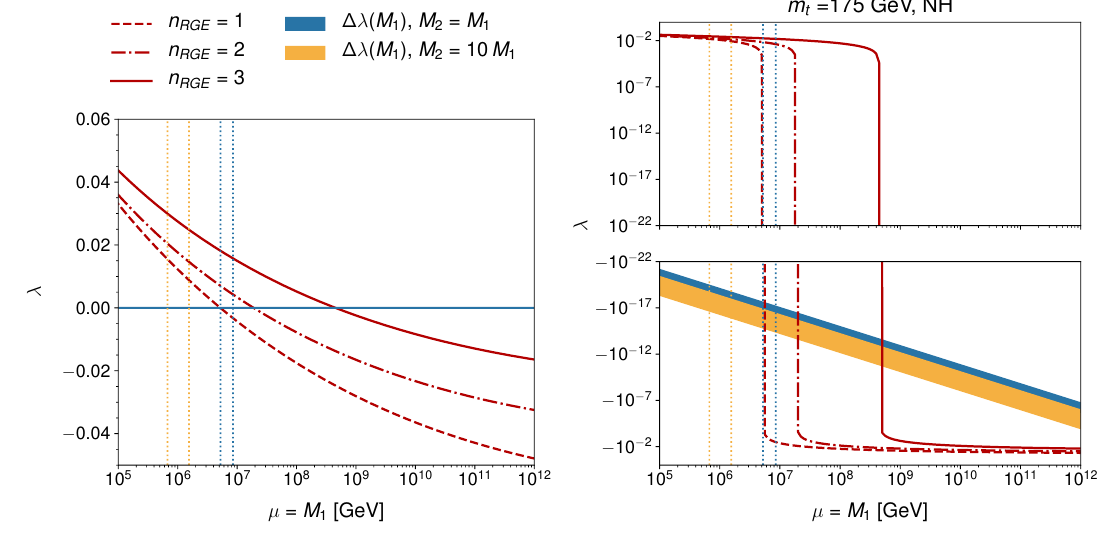
Figure 5 . Same as (cid:12)gure 4, for a top mass ^ m t = 175